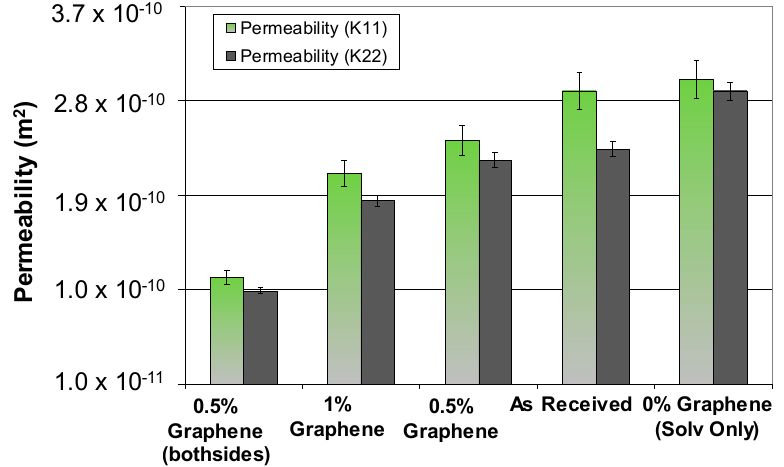
Figure 8. Transient permeability results of different percentages of graphene coated glass fiber